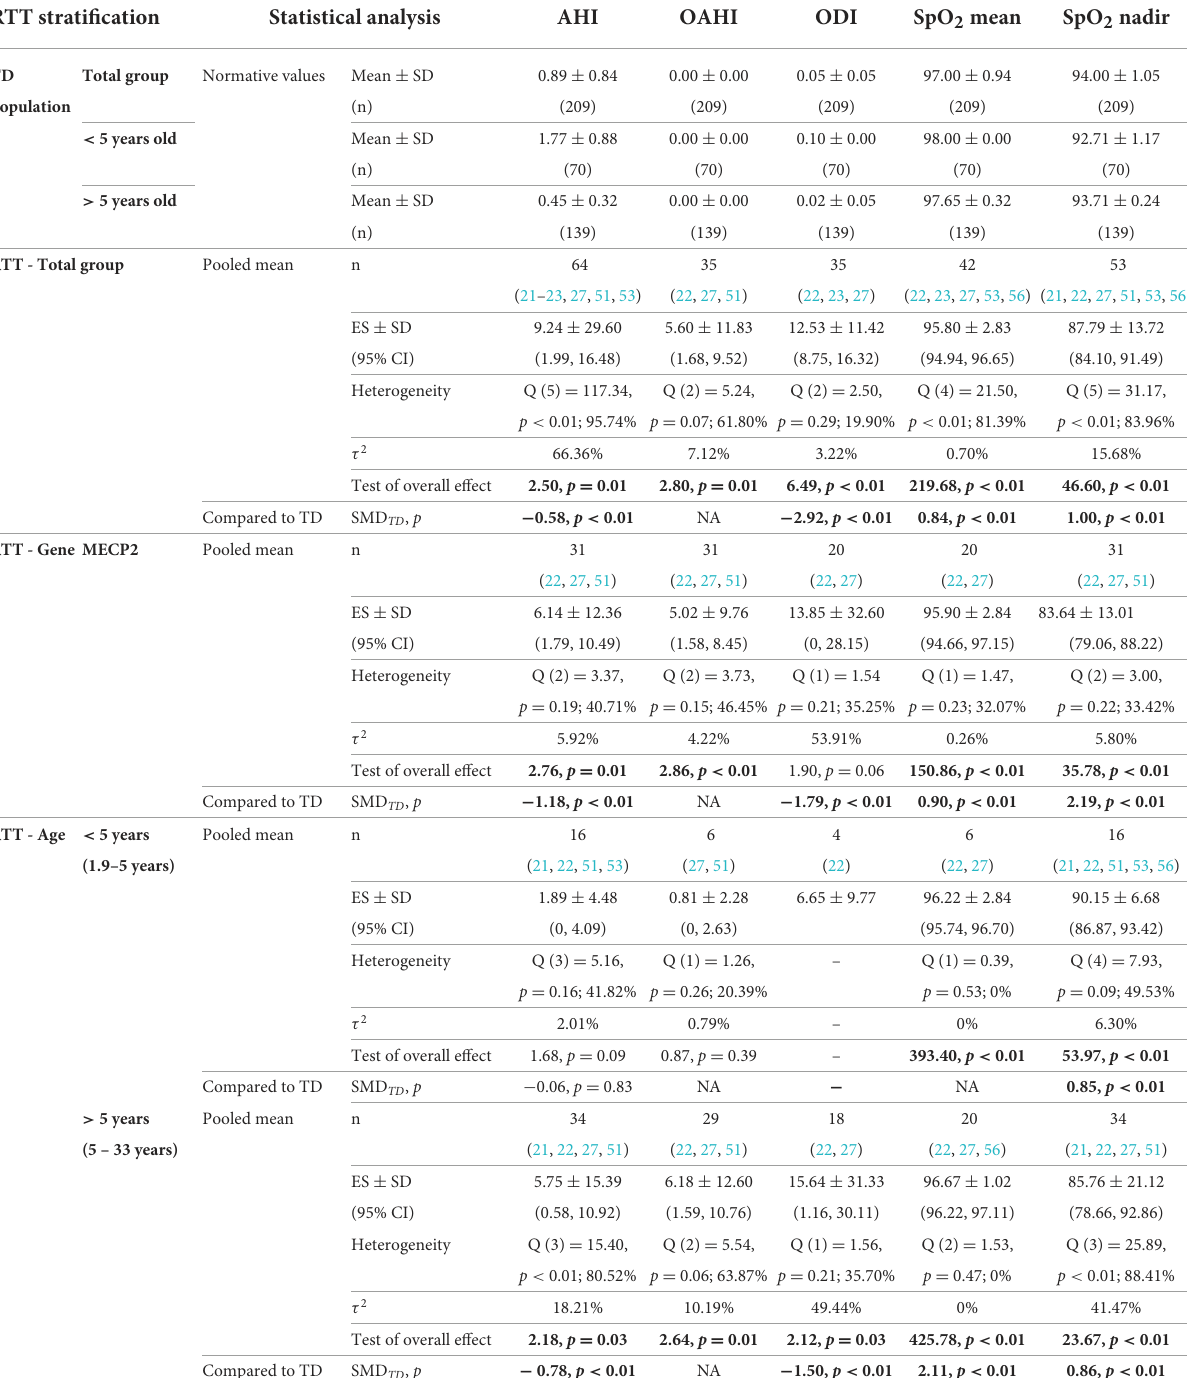
TABLE 4 Pooled mean of sleep respiratory indexes in RTT subjects and the comparison with literature normative values for typically developing population (50) (Part